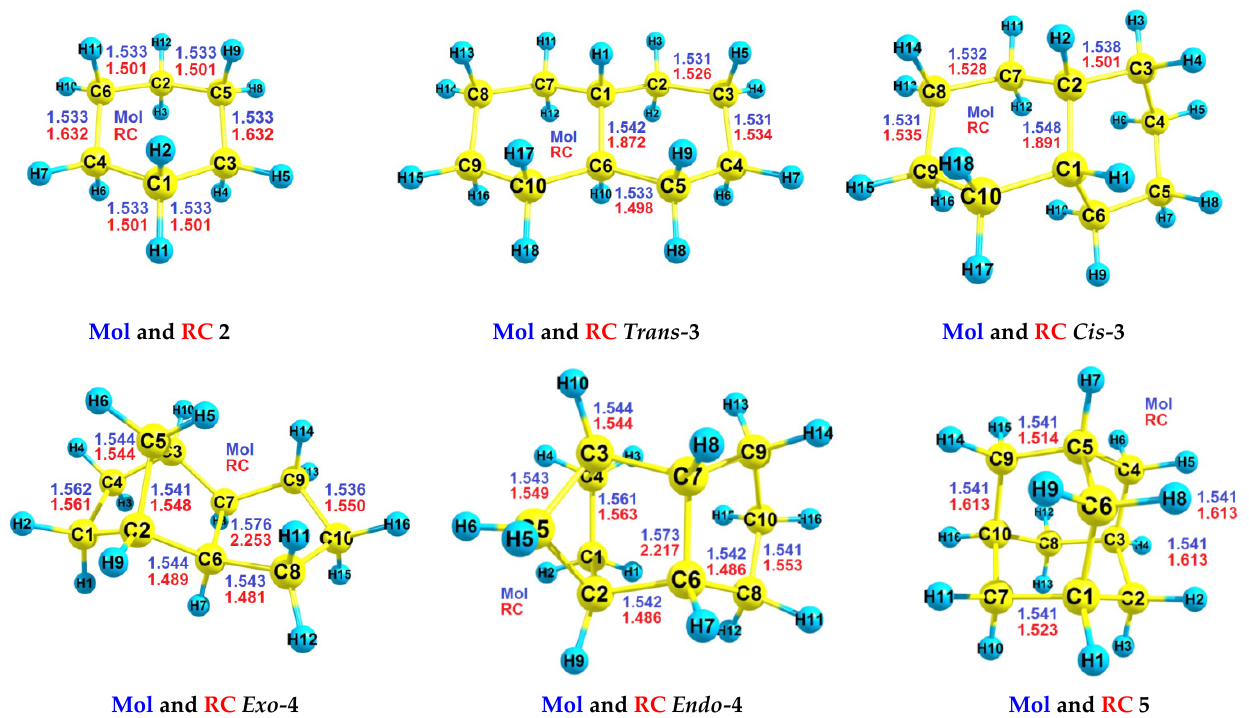
− 390.236902273183 Figure 4. Correlations between DFT calculated and experimental values of AIP ( left ) and VIP ( right ): AIP(Exp) = 1.0363AIP(DFT), R 2 = 0.9988 (blue); AIP(Exp) = 1.051AIP(DFT), R 2 = 0.9982 (red); VIP(Exp) = 1.0178VIP(DFT), R 2 = 0.9223 (black). Due to the much larger spread, all points are combined into one correlation (black) in the case of VIP values (Figure 4(right)). Estimated by us from the experimental spectrum and from DFT calculation values of